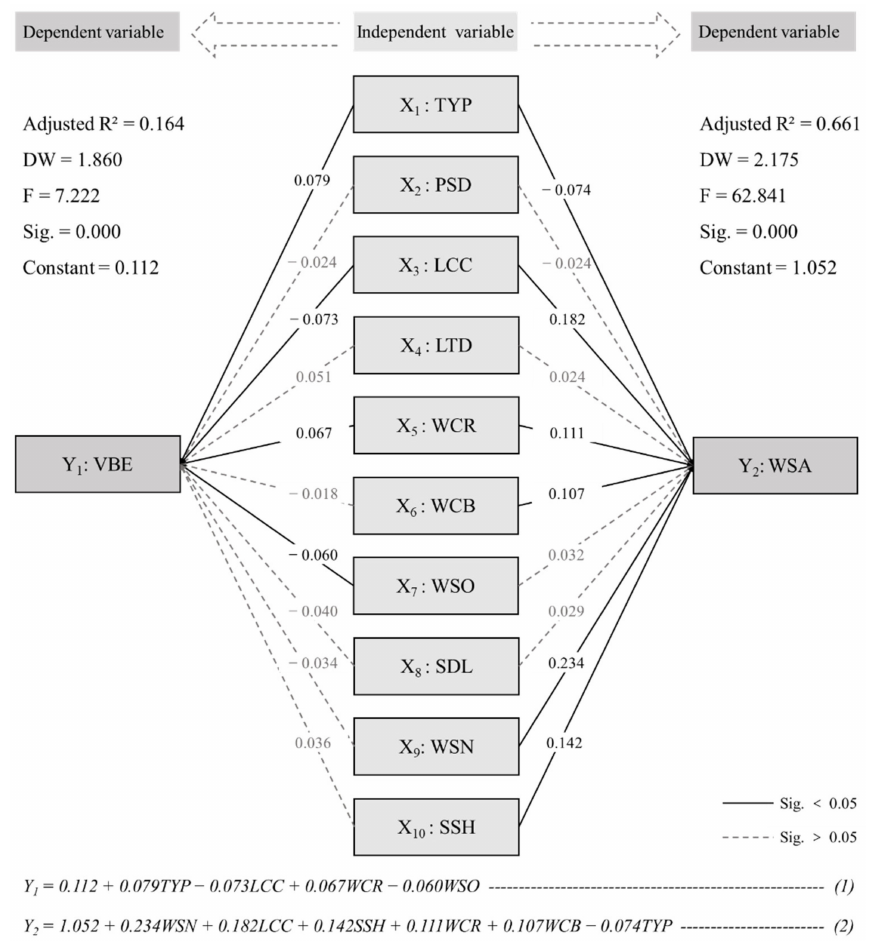
Figure 7. Spatial perception factors that affect visual behavior and satisfaction preference for for- est recreation landscape space. Note: TYP: forest recreation landscape spatial type; PSD: whether the plant species are diverse; LCC: whether the landscape content is changing; LTD: whether the near-middle landscape is three-dimensional; WCR: whether the color is rich; WCB: whether the color is bright; WSO: whether the space is open; SDL: can you see the distant landscape; WSN: whether the space is neat; SSH: whether the space has a sense of hierarchy; VBE: the evalua- tion of visual behavior; WSA: Whether you are satisfied it. This figure was created by Yu Gao (Shenyang Agricultural